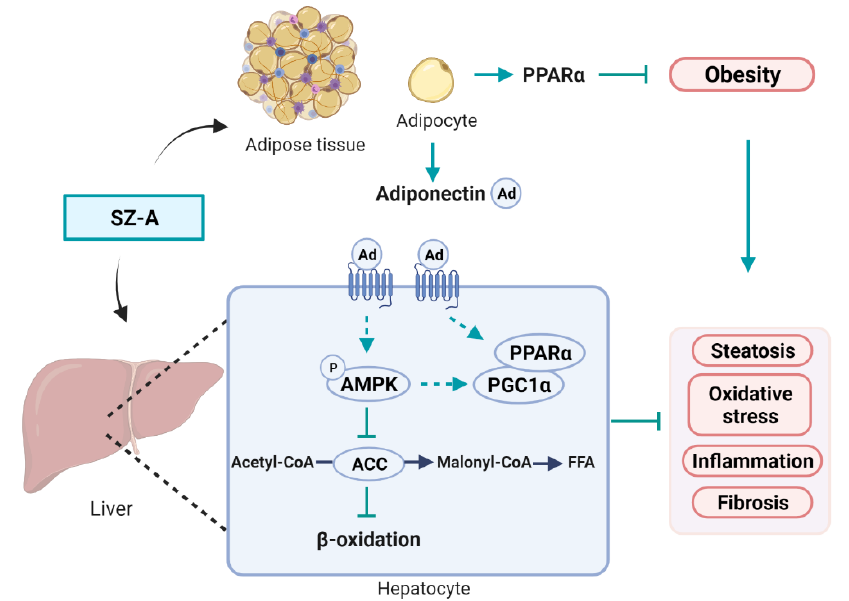
Figure 9. Graphic illustration of the mechanism underlying the SZ-A-mediated improvement of HFD-induced obesity and NAFLD. SZ-A is distributed in the liver and adipose tissue after intragastrical and intraperitoneal administration. SZ-A protects mice from HFD-induced obesity without affecting food consumption. The weight-loss effect contributes partly to the protective effect on NAFLD. Besides, SZ-A may also have direct effects on hepatocytes. AMPK and PPAR signaling pathways are involved in the protective effect. SZ-A, Ramulus Mori (Sangzhi) alkaloids; Ad, adiponectin; AMPK, AMP-activated protein kinase; ACC, acetyl-CoA carboxylase; PGC1 α , peroxisome proliferator-activated receptor- γ co-activator 1 α ; PPAR α , proliferator-activated receptor- α ; FFA, free fatty acid. Dashed lines indicate indirect effect. Created in BioRender.com, accessed on 4 April